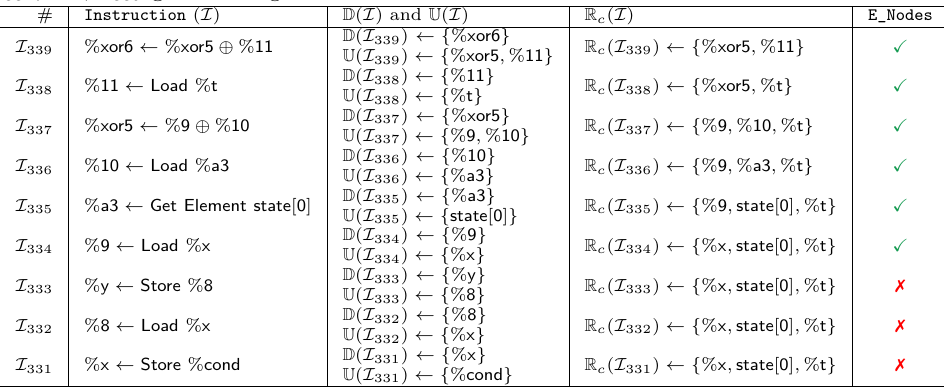
Table 4: Result of Exploitable_Node_Detection (Algorithm 2) for instructions I 331 , I 332 , · · · , I 339 given in Figure